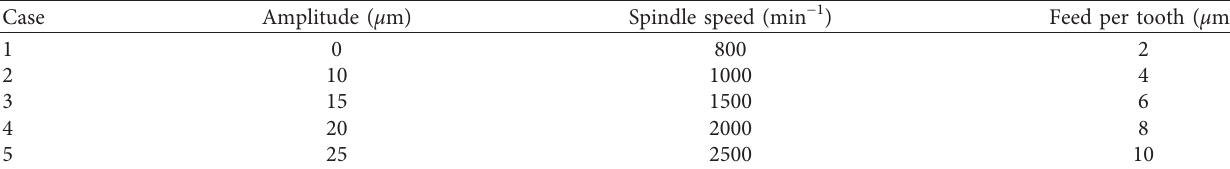
Table 4: Level of experimental factors.